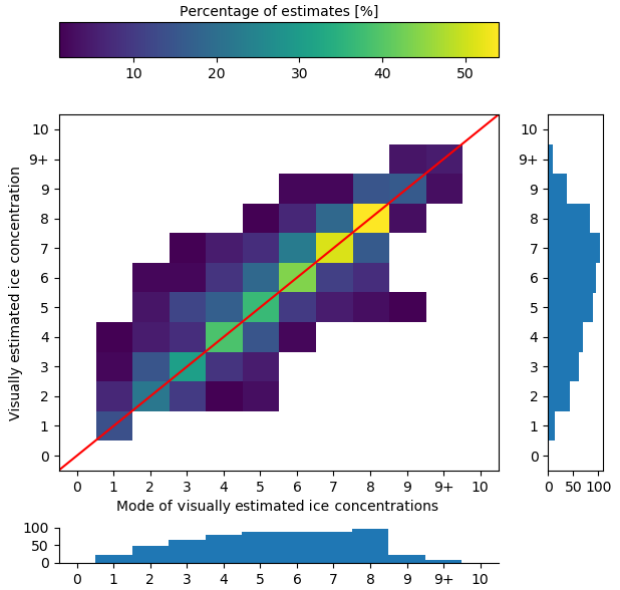
Figure 16. The contingency table of ice concentration visually esti- mated by the analysts (on the vertical axis) compared to the mode of ice concentration estimates by analysts (horizontal axis). The red di- agonal line shows the location where perfect agreement between es- timation and the modal estimate would occur. The histogram below shows the (marginal) distribution of ice concentration by mode. The vertical histogram shows the (marginal) distribution of estimates of ice concentration by analysts.